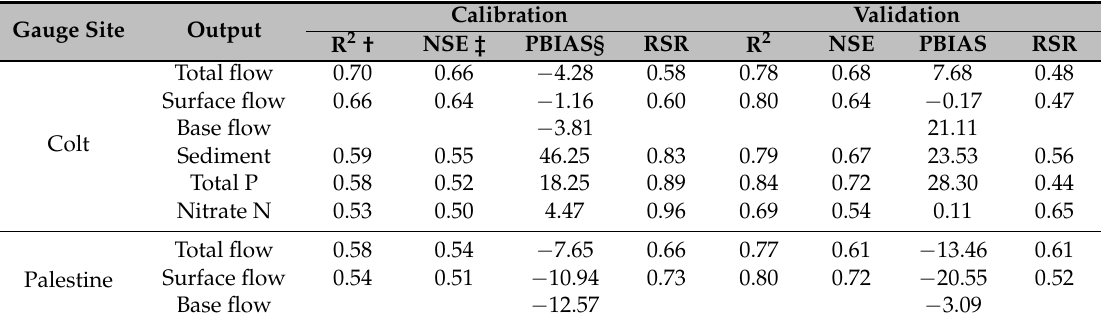
Table 8. Results for the monthly calibration and validation of the LRW SWAT